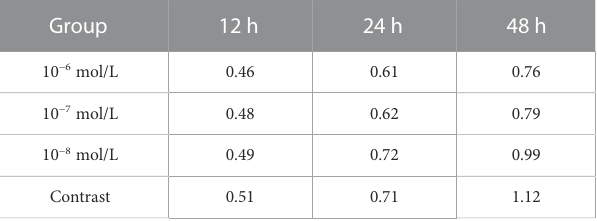
TABLE 5 Difference of in fl uence of different time and